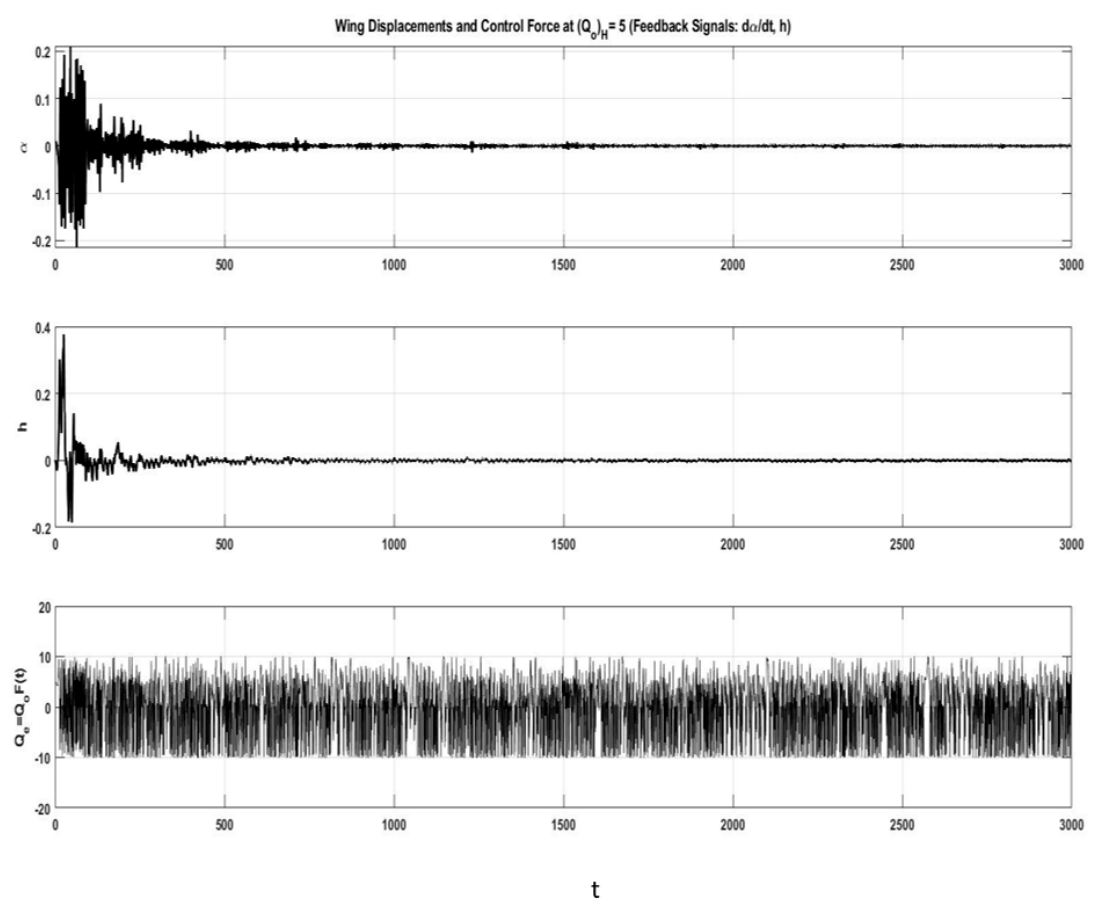
(cid:104) (cid:105) . α t ) + sin ( ht ) cos ( , Q o = 5